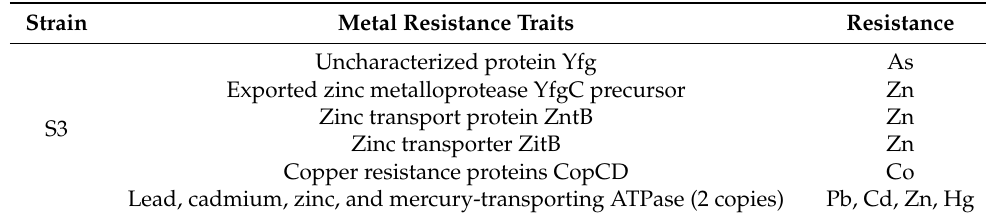
Table 2. Metals and metalloids resistance traits identified in the sequenced whole genomes of the strains selected for the design of the TSA and MA